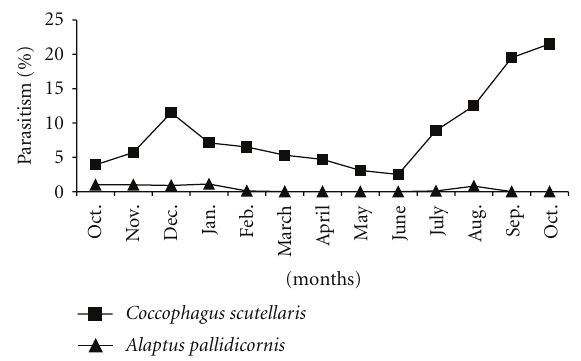
Figure 3: Percent parasitism of Coccophagus scutellaris and other associated parasitoids of Ceroplastes rusci on citrus in Beni Seuf governorate after releasing during 2009-2010.